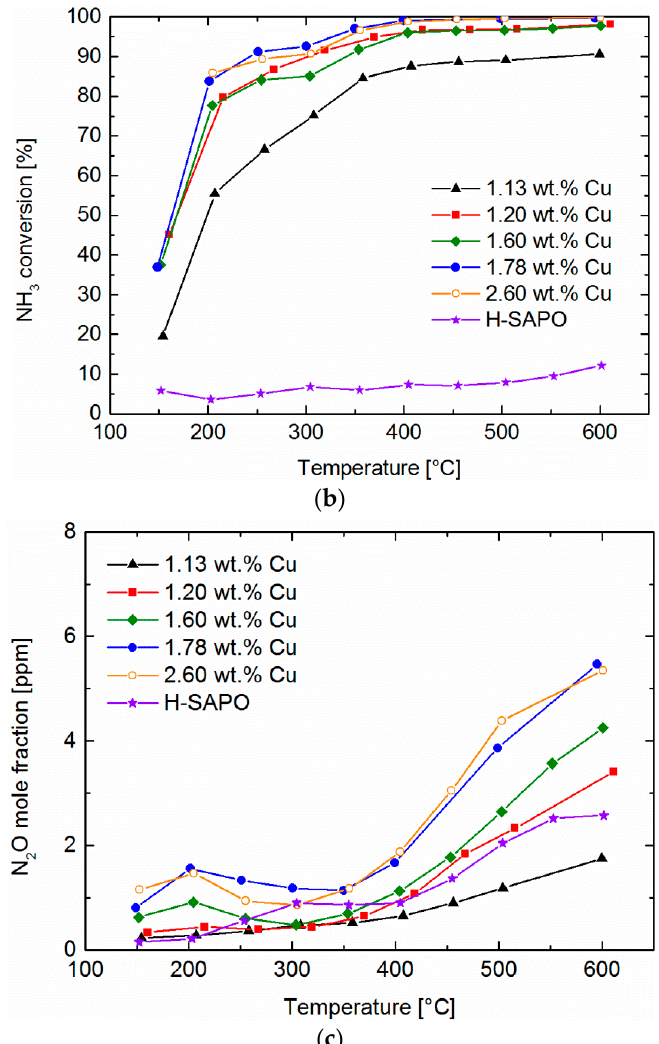
Figure 6. Standard selective catalytic reduction (SCR) steady state activity. Inlet: 400 ppm of NH 3 , 400 ppm of NO, 8% O 2 , 5 % H 2 O. ( a ) NO conversion; ( b ) NH 3 conversion; ( c ) N 2 O production.